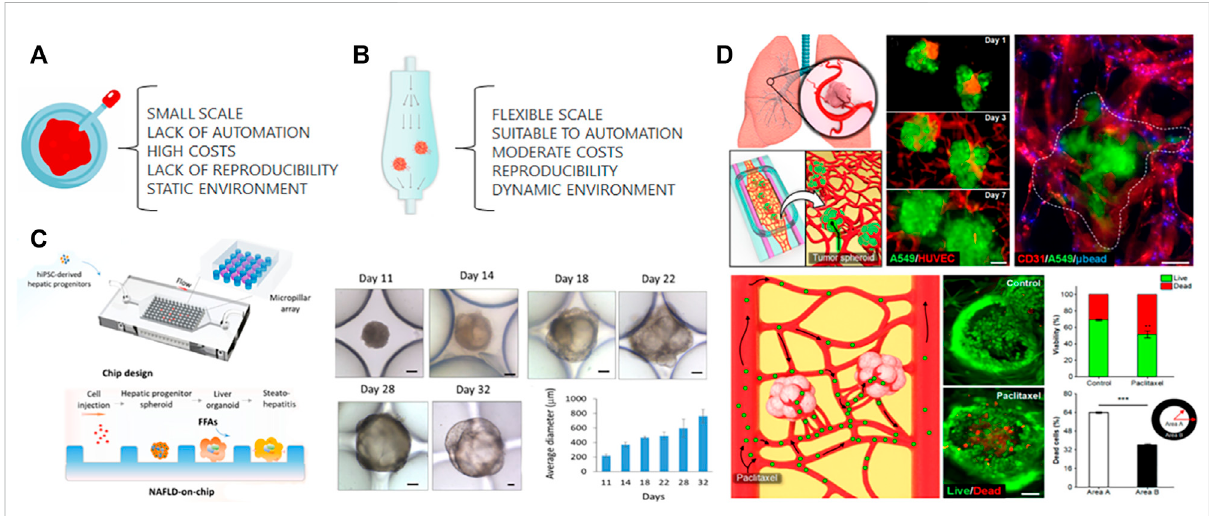
FIGURE 1 Organoids culture. (A) Traditional organoid culture relies on several disadvantages that can be partially solved by culturing organoids in a micro fl uidicchip (B) .Thelaminar fl owofmicro fl uidicsprovidesacontrolleddynamicenvironmentincreasingthereproducibilitywhilereducingcost of organoid culture. The large scale can be reached by parallel micro fl uidic devices. (C) The cell suspension of iPS-derived hepatic progenitors cells were injected inside a micro fl uidic chip to form spheroids maturated into liver organoids. The maturation was followed by an increase on their average diameter during organoid culture. “ Adapted with permission from Wang et al., 2020. Copyright 2020 American Chemical Society. ” (D) Co- culturespheroidsfromhumanlungadenocarcinomacells(A549)andendothelialcells(HUVECs)weretransferredtoamicro fl